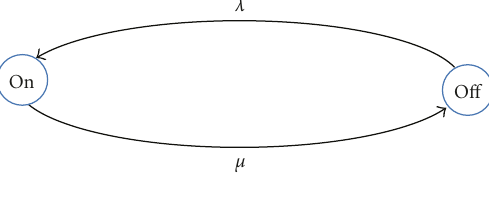
Figure 7: Markov model for a